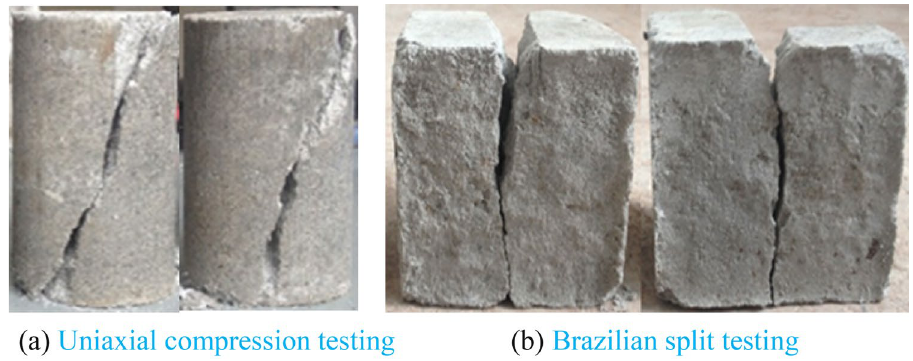
Figure 1. Composite material failure in T-C measurements.